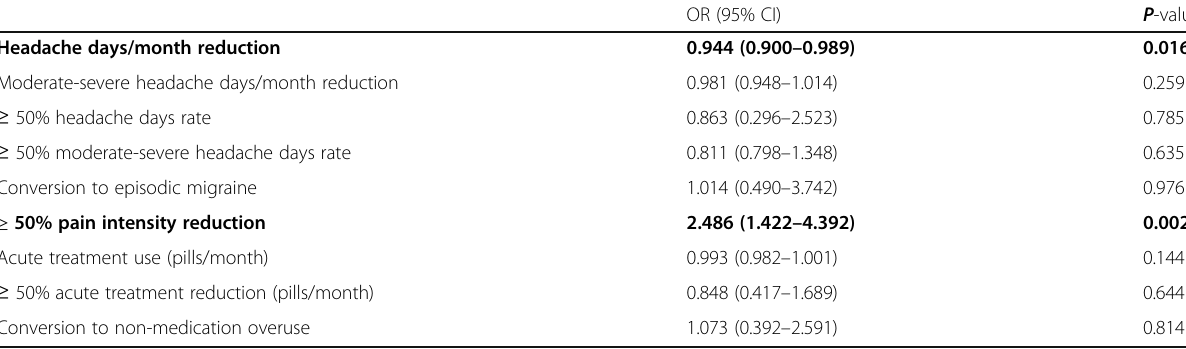
Table 3 Logistic regression model for ≥ 50% MIDAS score reduction rate